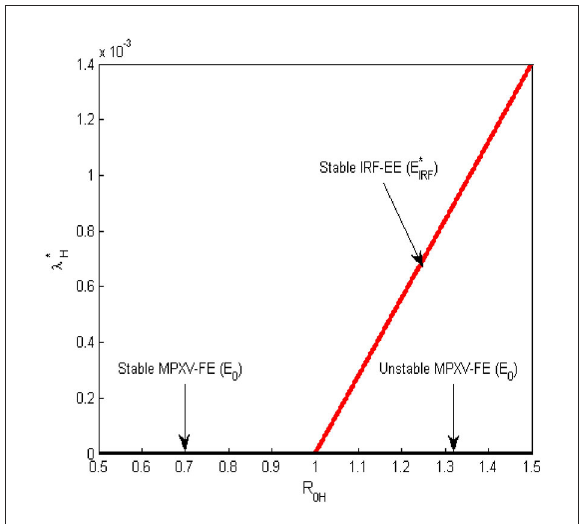
FIGURE2 Forward bifurcation plot for the transmission dynamics of the MPX infection at the human-human and environment reproduction number ( R 0 H ) =